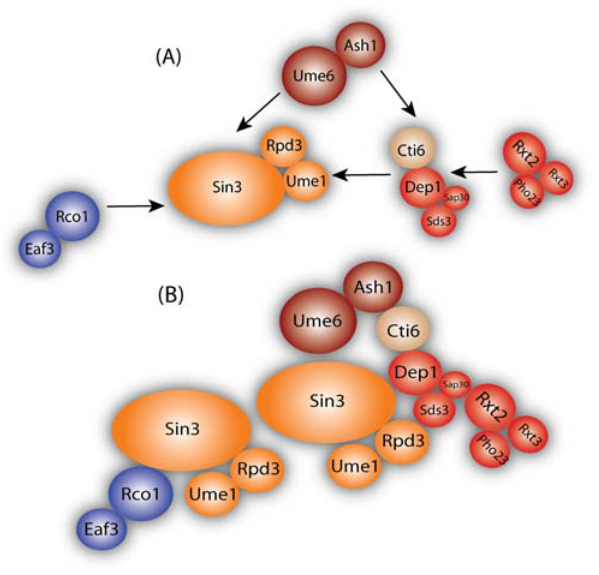
Figure 5. Assembly of the RPD3 complexes. (A) We positioned all subcomplexes next to the module based upon above observations, however we placed the first subcomplex in closer proximity of the module since its members affected the stability of the module. (B) Final assembled complex. Red proteins correspond to the proteins in the RPD3L, blue corresponds to the proteins in the RPD3S and the shared module was colored in orange. The two sequence specific repressors Ash1 and Ume6 are colored in dark red and Cti6 in light brown. The size of the inset circles corresponds to the molecular weights of the proteins